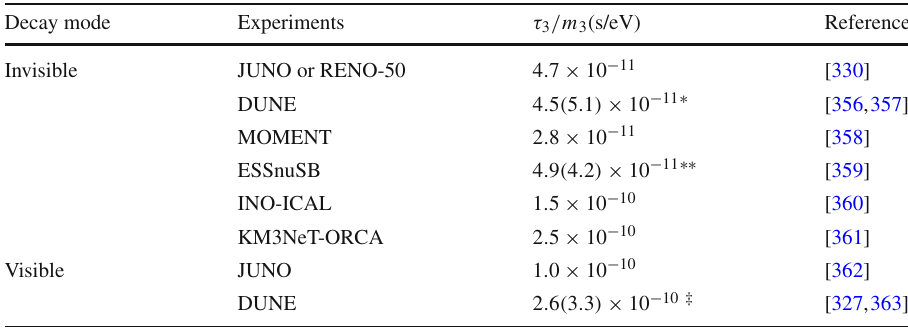
Table 3 Expected sensitivities to τ 3 / m 3 at 90 % CL. Values are provided for visible/invisible decay and calculated for atmospheric, reactor and long-baseline neutrino experiments, as